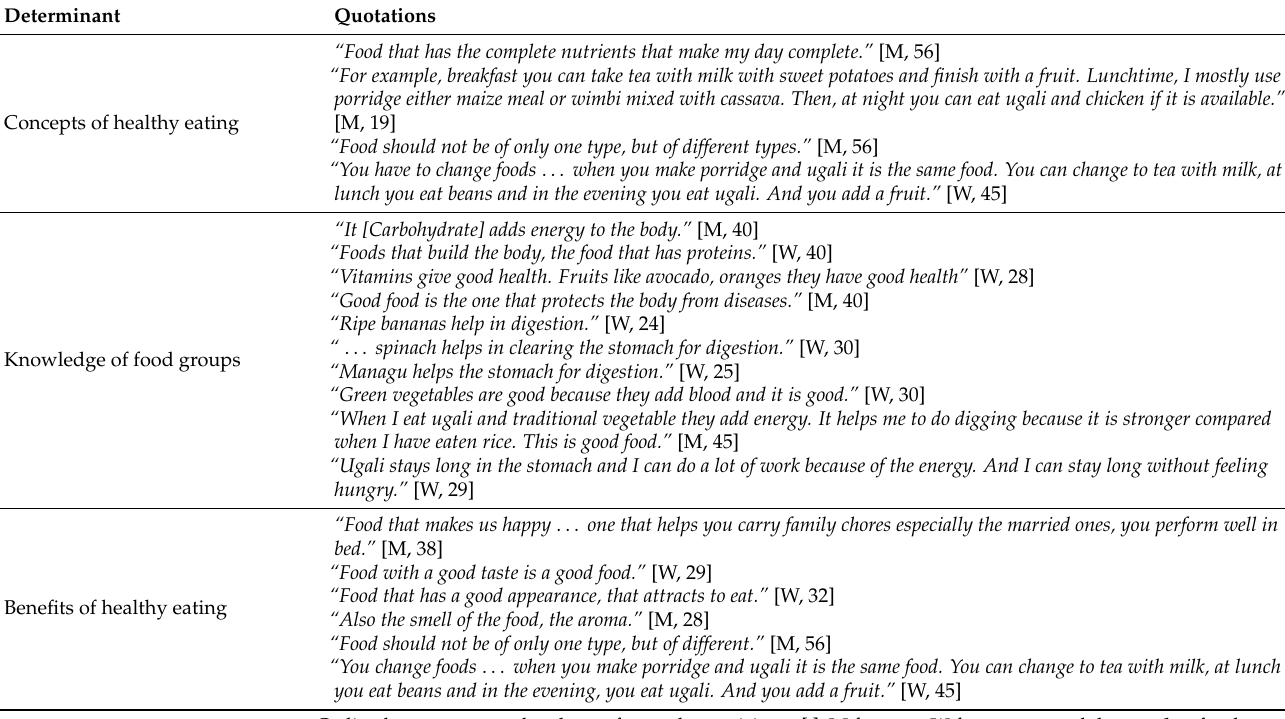
Table 4. Cognitive determinants of healthy eating and quotations from participants of Focus Group Discussions in Vihiga County,